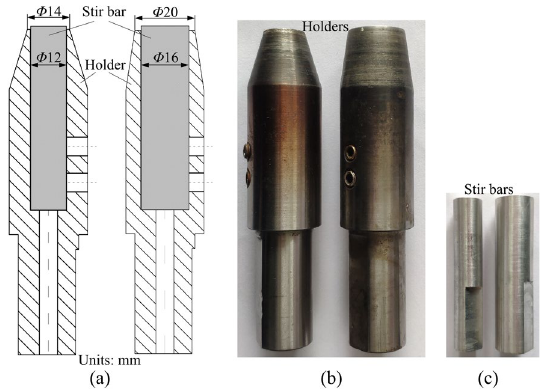
Figure 1. The geometry of the VFSW tool: ( a ) dimensions of the holders; ( b ) the holders used; ( c ) the stir bars before welding.